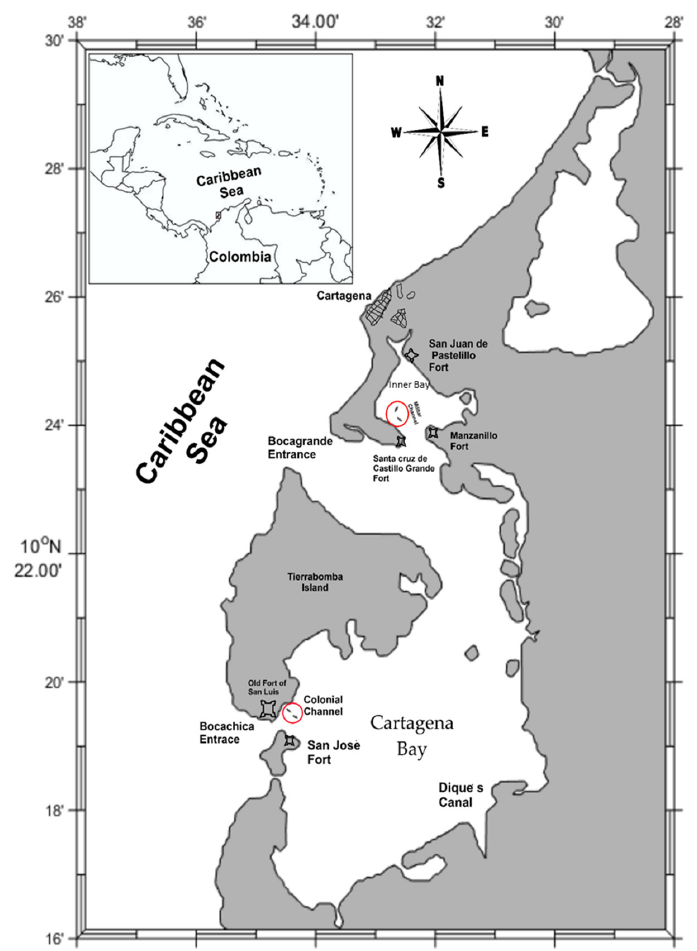
Figure 1. Location of the study area, Cartagena de Indias Bay, Colombia. The four shipwrecks are highlighted with two red circles and are located in the Inner Bay ( Conquistador and Dragón ) and in Bocachica ( África and San Carlos ).